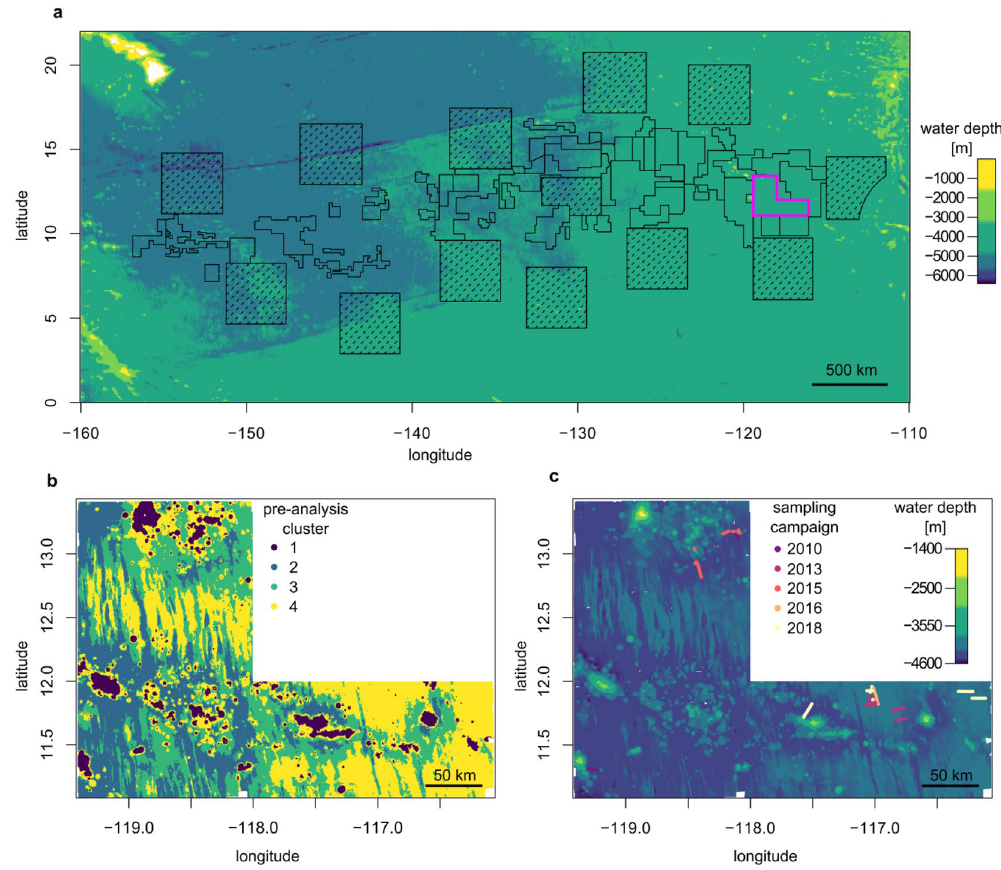
Figure 5. Bathymetric map of the Clarion Clipperton Fracture Zone in the north-east Pacific with the study area, which is the German contract area for polymetallic nodule exploration, marked in magenta ( a ); a more detailed bathymetric map of the German contract area including the positions of the deep-sea images used in this study obtained at five cruises between 2010 and 2018 ( c ); distribution of the k-means clusters based on bathymetry used to obtain random subsamples of images including different bathymetric conditions ( b ).